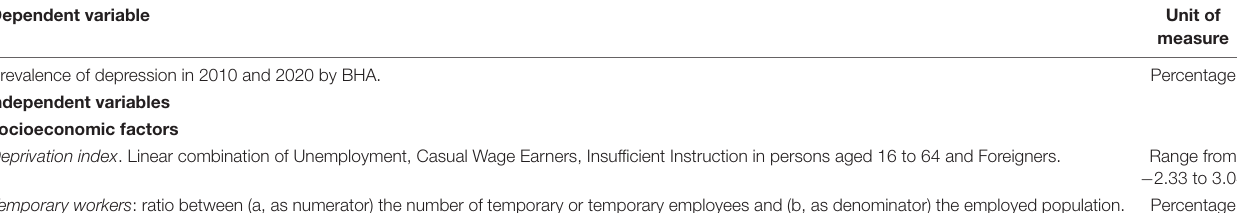
TABLE 1 | Variables of the study, indicators, and units of measure.